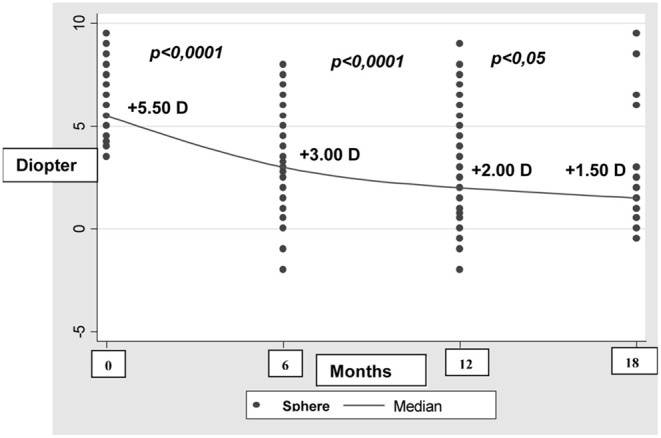
Trends in pathologic hyperopia during the first year of life.